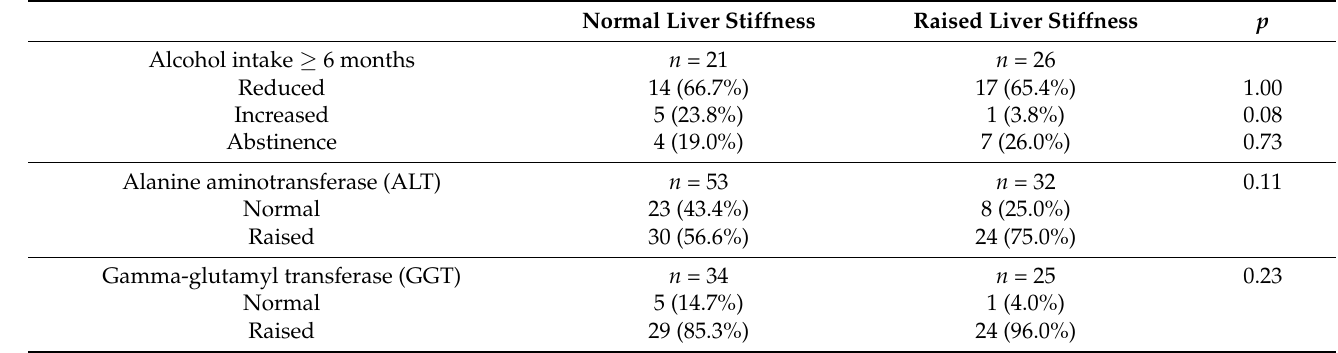
Table 2. Comparison between normal liver stiffness versus raised liver stiffness